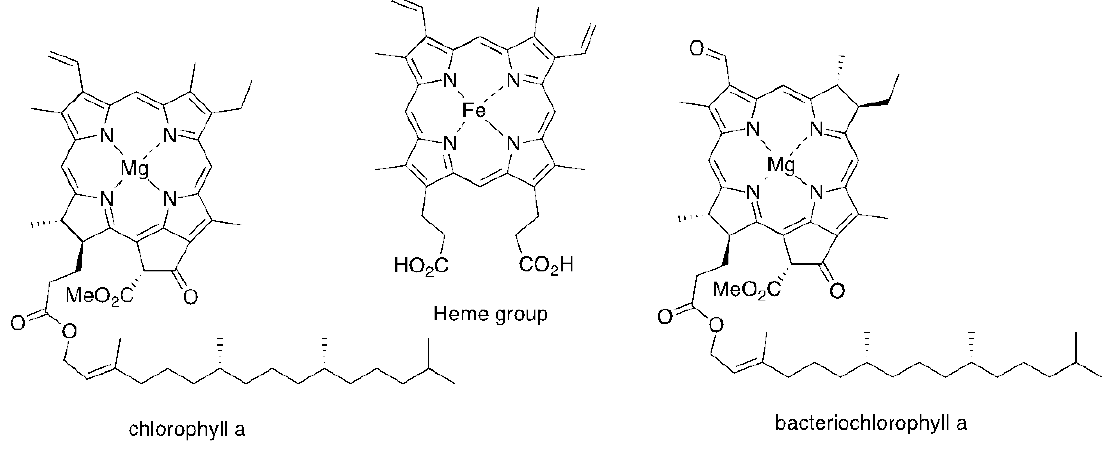
Figure 1. Structure of some tetrapyrrolic macrocycles with natural occurrence.